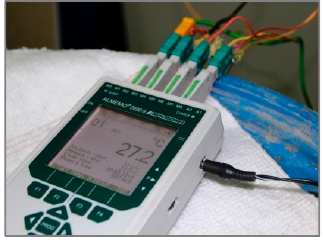
Figure 6. Samples in furnace.